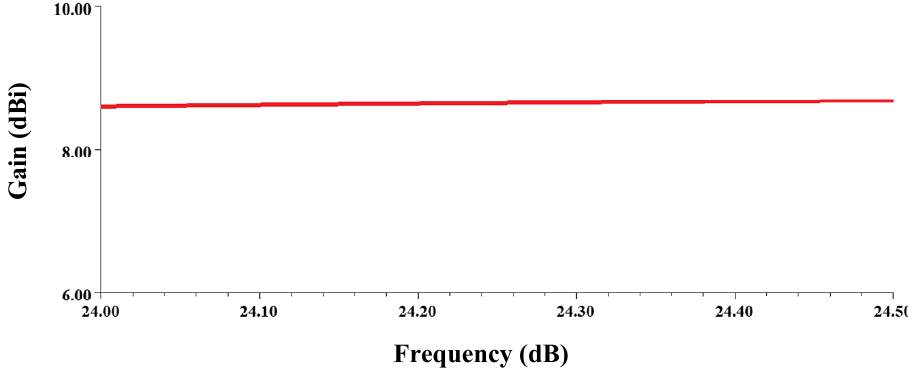
Figure 12. The gain results of the proposed antenna.